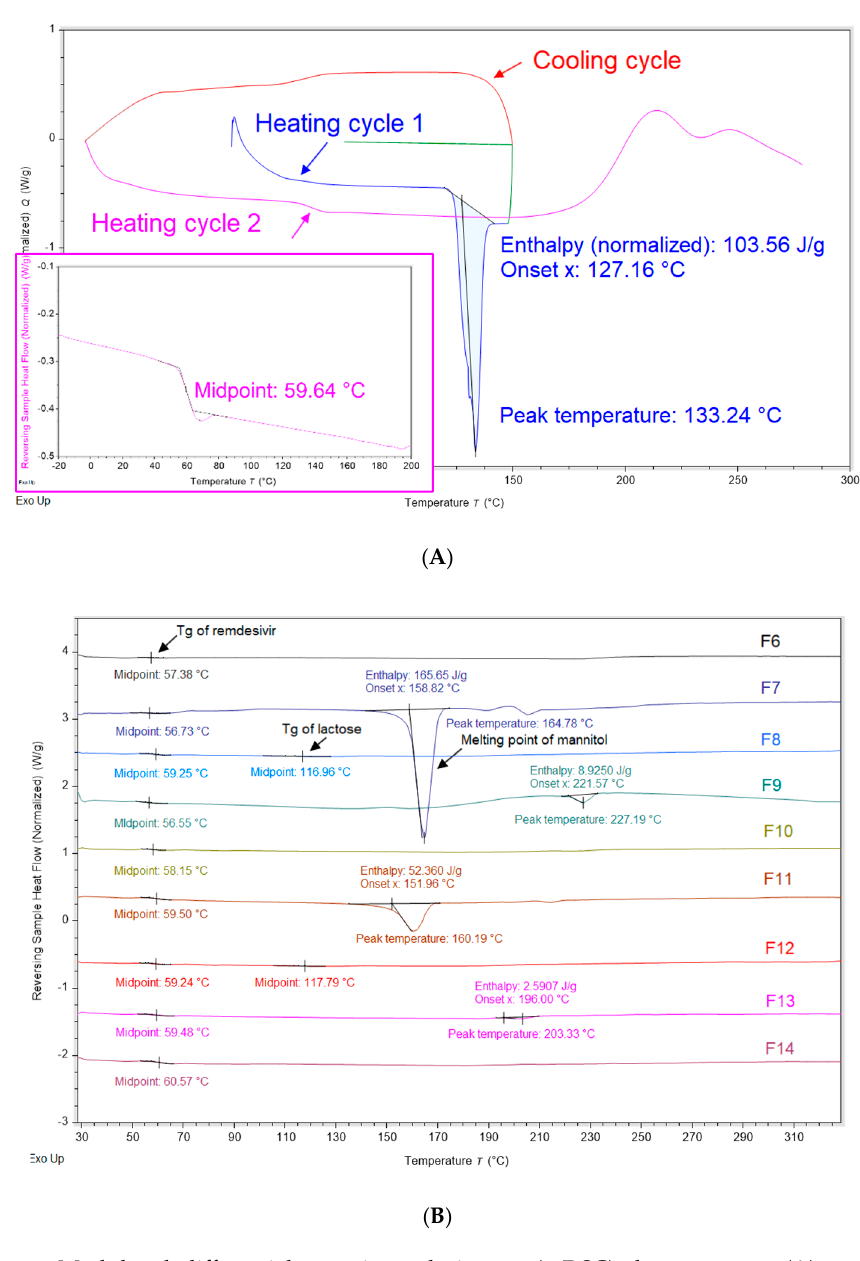
Modulated di ff erential scanning calorimetry (mDSC) thermograms; ( A ) remdesivir Figure 3. Modulated differential scanning calorimetry (mDSC) thermograms; ( A ) remdesivir unprocessed powder; ( B ) TFF remdesivir powder unprocessed powder; ( B ) TFF remdesivir powder formulations.